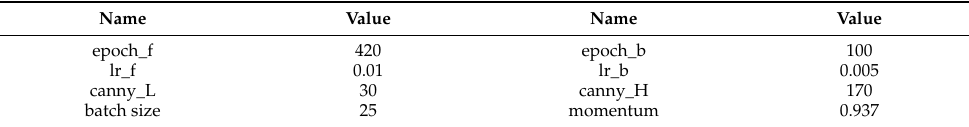
Table 3. Implementation details of training and